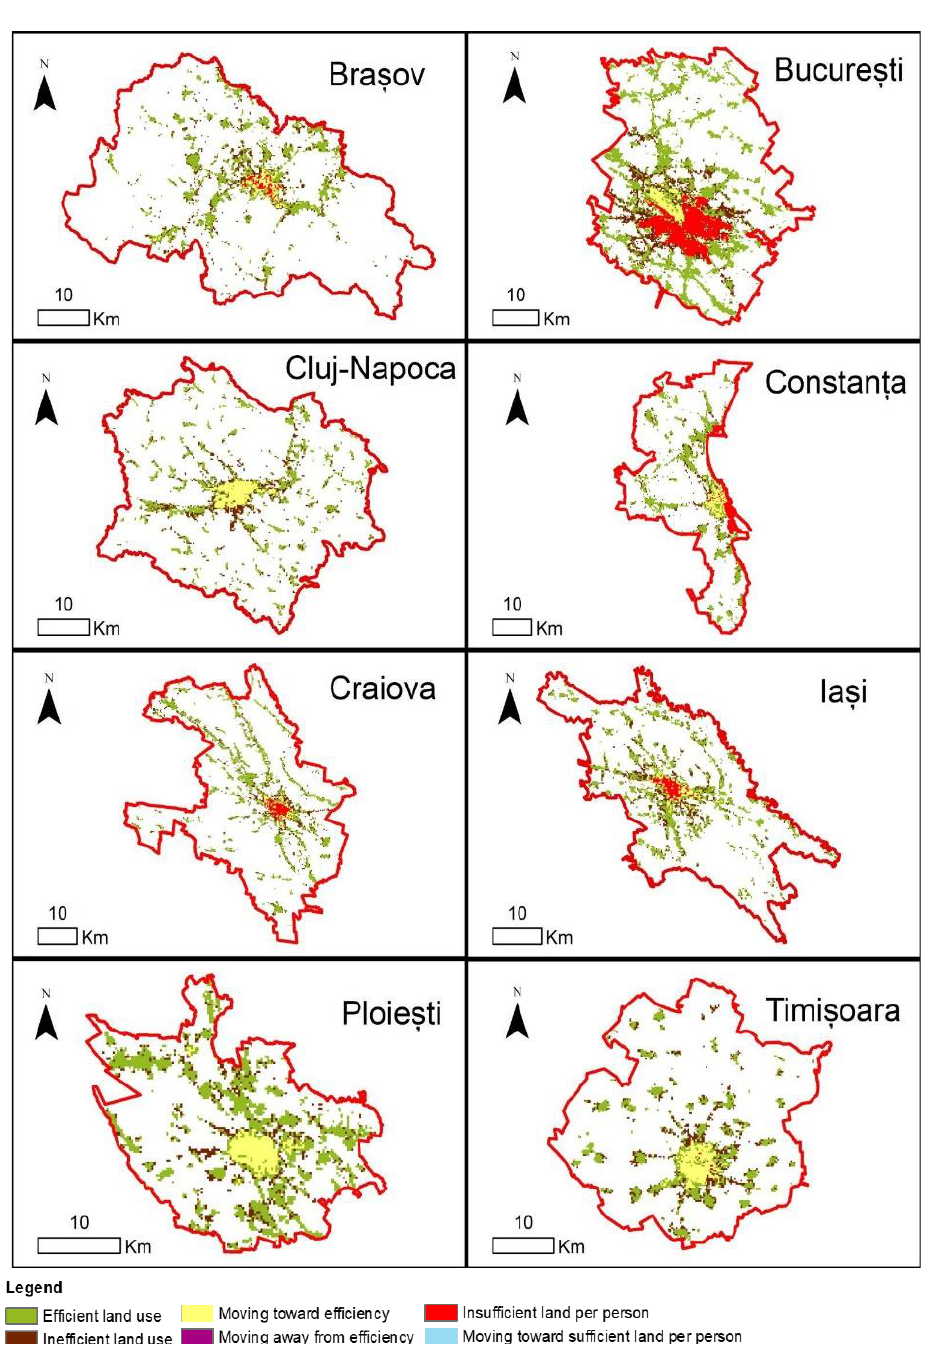
Figure 5. The LCRGR classes at grid level for 2000 – 2014.